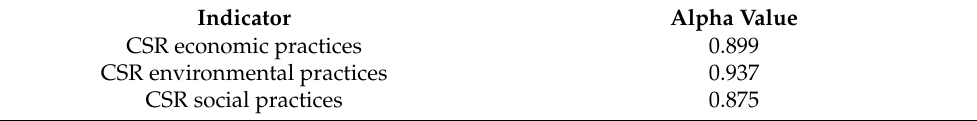
Table 3. Values of the Alfa Cronbach test reliability coefficient for individual indicators.